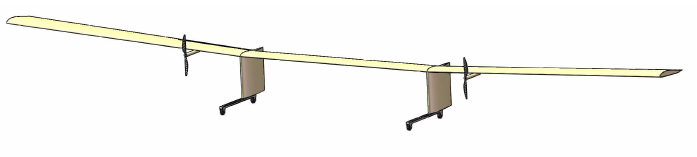
Figure 1. High aspect ratio full-wing